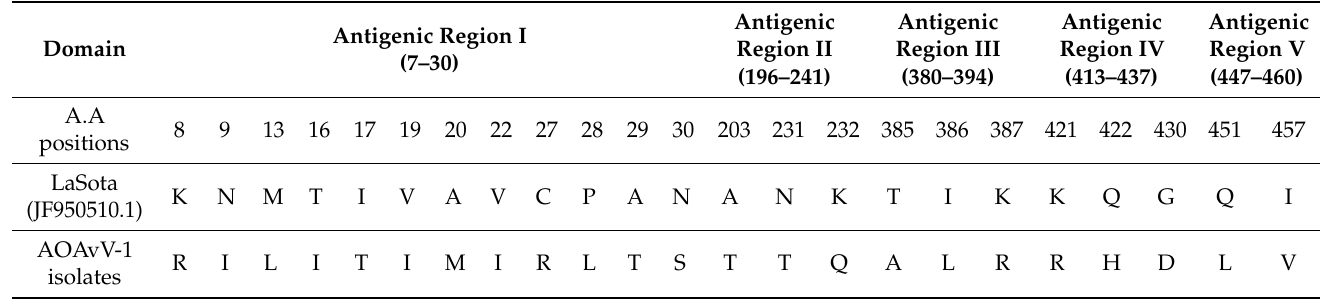
Table 3. Analysis of mutations in the predicted F protein antigenic domains structure between LaSota vaccine and our AOAvV-1 isolates reported in this study.